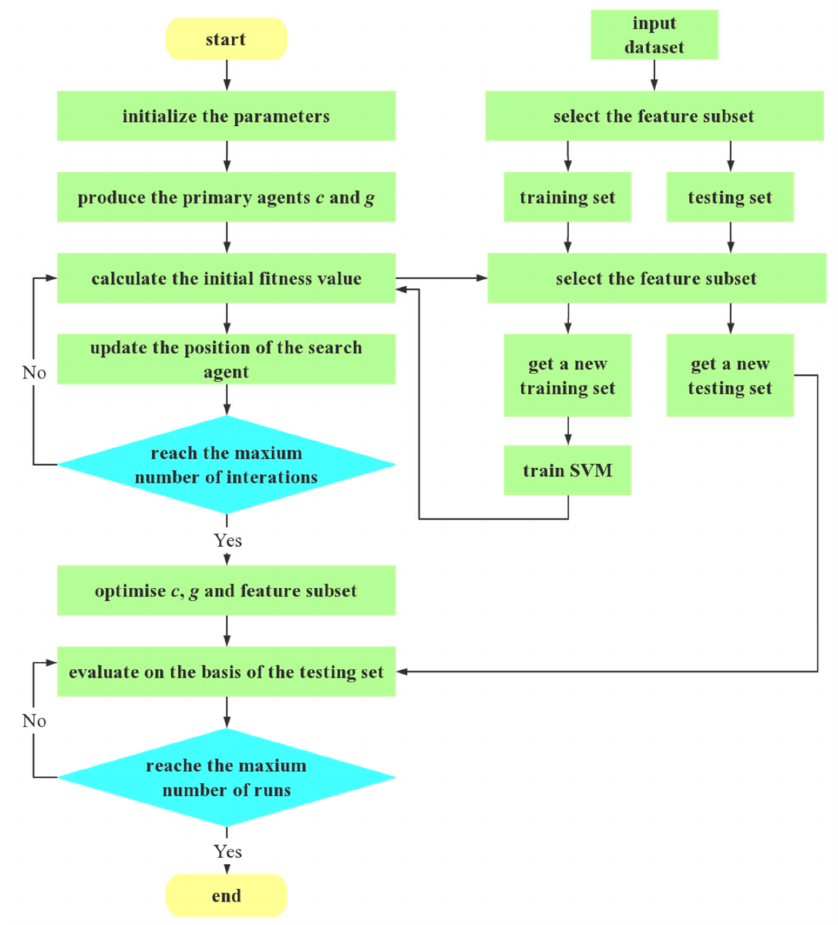
Figure 2. The flow chart of